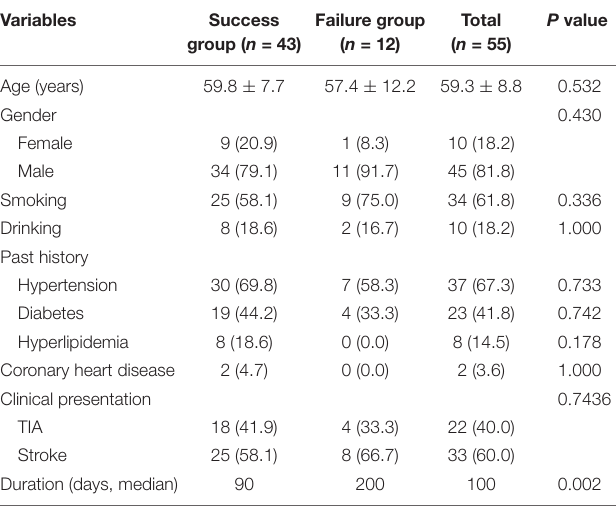
TABLE 1 | Baseline characteristics of